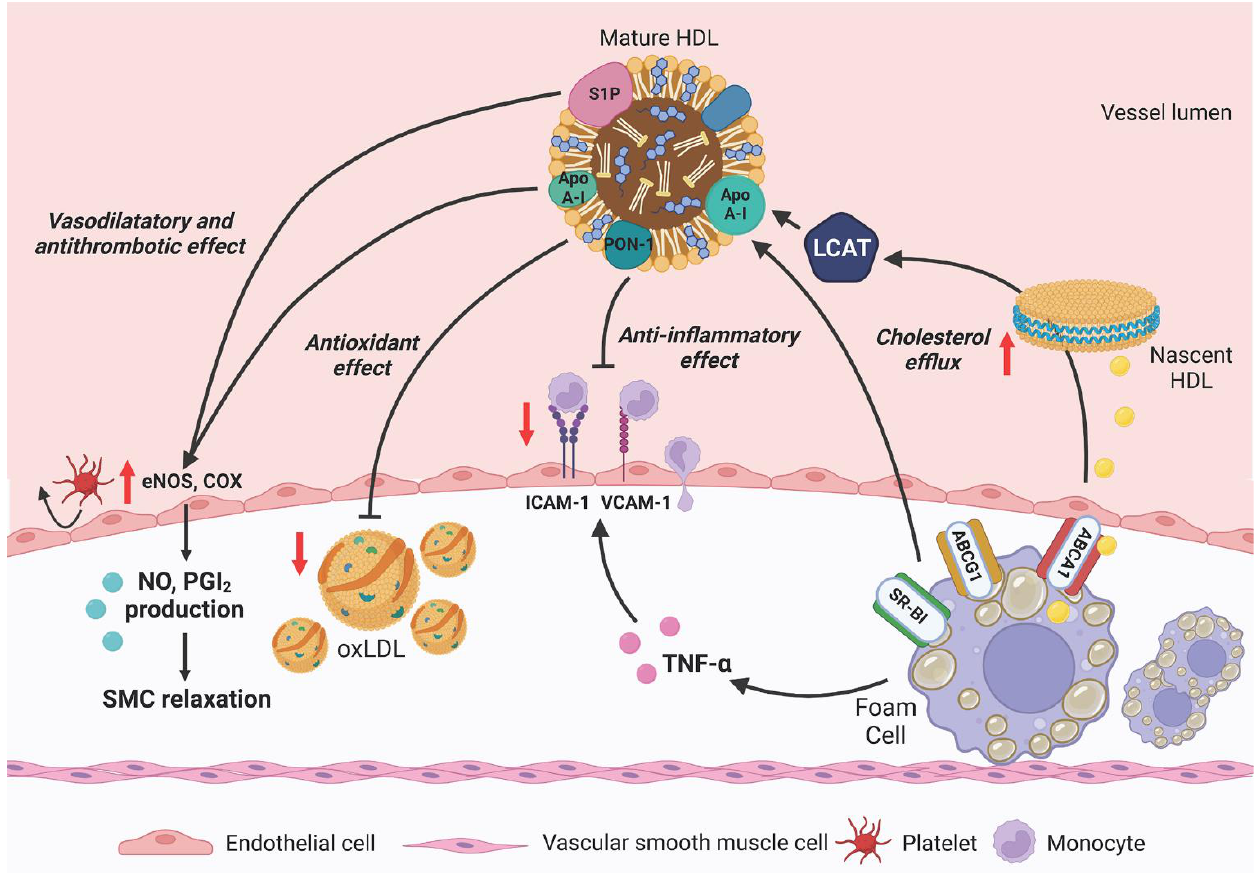
Figure 3. Atheroprotective functions of HDL on the vascular wall. High-density lipoproteins (HDL) are the main acceptors of cholesterol from peripheral cells through the interaction with the ATP-binding cassette transporters A1 and G1 (ABCA1 and ABCG1), and the scavenger receptor type BI (SR-BI). Cholesterol within HDL is then esterified by lecithin:cholesterol acyltransferase (LCAT). Through their protein and lipid cargo HDL can inhibit the oxidation of low-density lipoproteins (LDL). HDL are also able to inhibit the cytokine-induced production of cell adhesion molecules (as ICAM-1 and VCAM-1) by endothelial cells, thus limiting the adhesion and extravasation of monocytes. HDL promote the release of nitric oxide (NO) and prostacyclin (PGI 2 ) by endothelial cells, which inhibit the adhesion of platelets and induce the relaxation of smooth muscle cells (SMC). Created with BioRender.